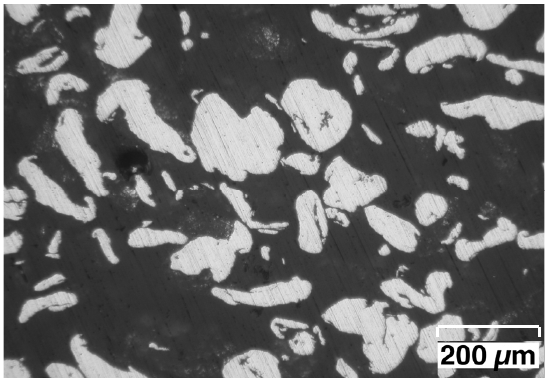
Figure 2. Optical micrograph of as received ground pure magnesium powder.